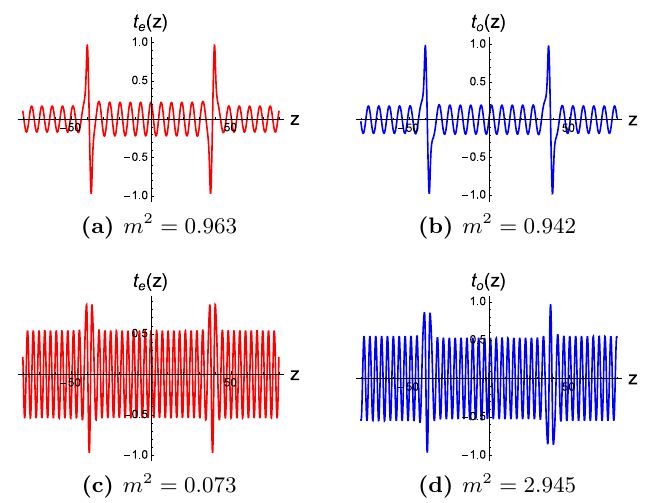
Figure 10. Plots of the even and odd parity resonance modes quasi-localized on the sub-branes for the double brane model (3.8). The parameters are set to k = 1, b = 7, and d = 2 : 6.